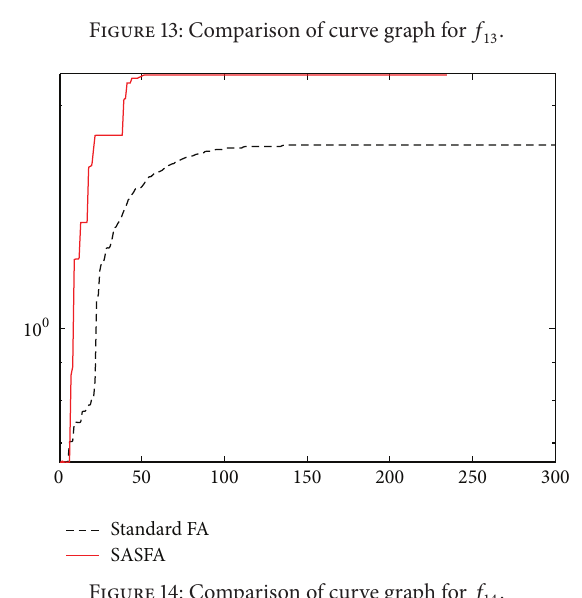
Figure 14: Comparison of curve graph for 𝑓 14 .